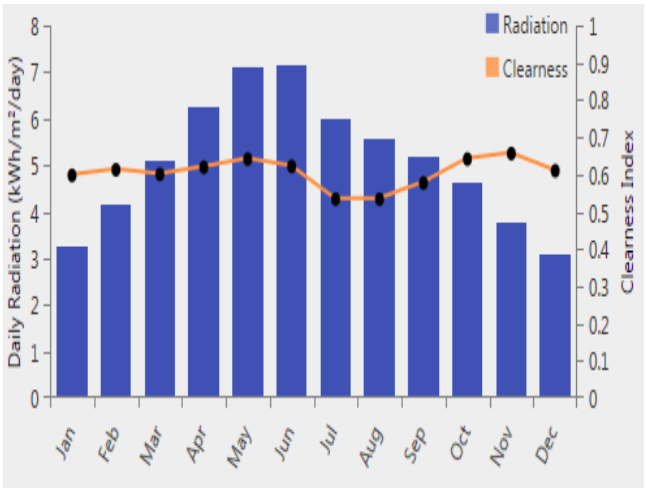
Fig. 2. Kallar Kahar solar radiations